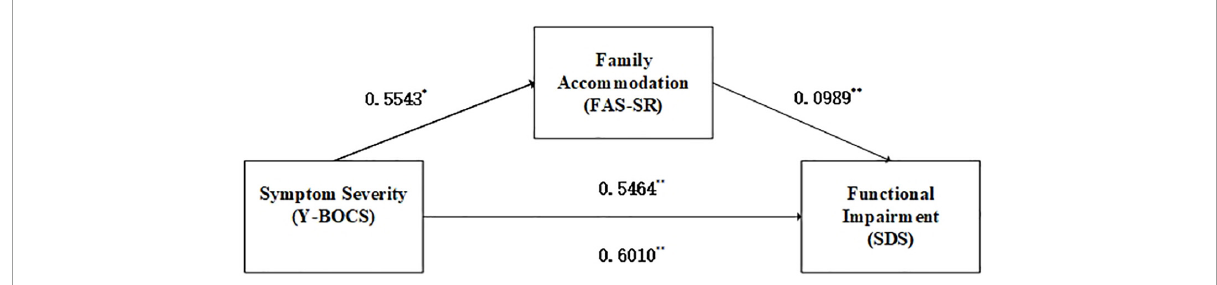
FIGURE1 Mediation effects of family accommodation on symptom severity and functional impairment. * P < 0.05, ** P < 0.01. Y-BOCS, Yale-Brown Obsessive-Compulsive Scale; FAS-SR, Family Accommodation Scale for OCD Self-rated version; SDS, Sheehan Disability Scale.